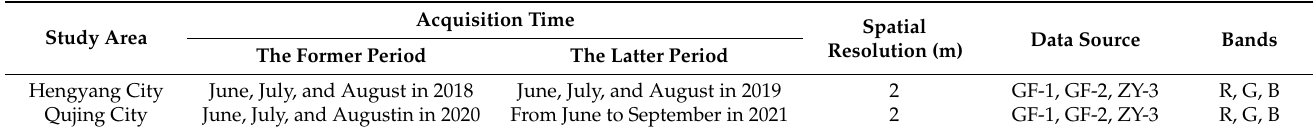
Table 1. The metadata information of remote sensing images in the study areas.